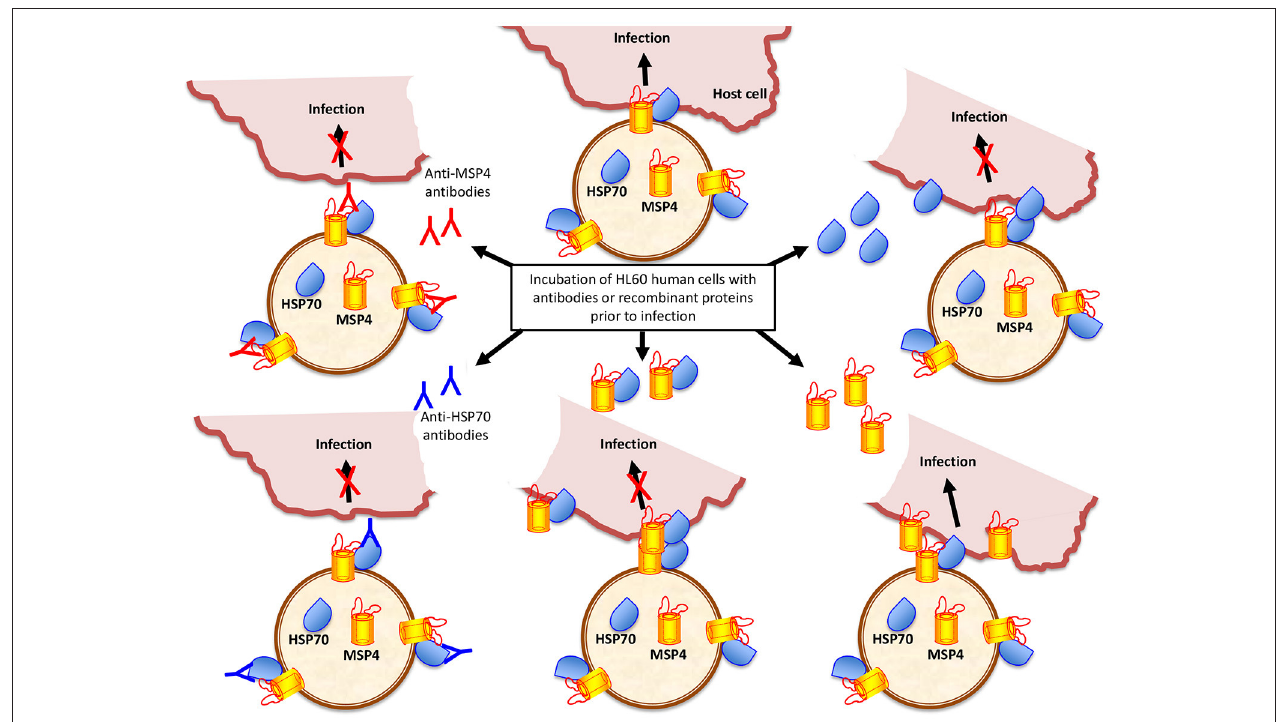
FIGURE 7 | Anaplasma phagocytophilum HSP70 and MSP4 are necessary for pathogen infection of host cells. Based on the results of this study, a model was developed to explain the role of HSP70 and MSP4 during pathogen infection of host cells. HSP70 and MSP4 form a complex on the bacterial membrane where MSP4 probably acts a doking protein for HSP70. The incubation of HL60 human cells with recombinant HSP70 or MSP4-HSP70 interacting proteins inhibits infection by interfering with pathogen interaction with host cells mediated by HSP70, which is necessary for infection. However, the addition of recombinant MSP4 does not affect infection because the interaction of bacterial HSP70 with host cells occurs and is sufficient for infection. The anti-MSP4 antibodies probably inhibit infection through binding to MSP4 at the MSP4-HSP70 interaction site, thus preventing HSP70 adhesion to host cells. The anti-HSP70 antibodies bind to HSP70 and prevent the interaction with host cells required for pathogen